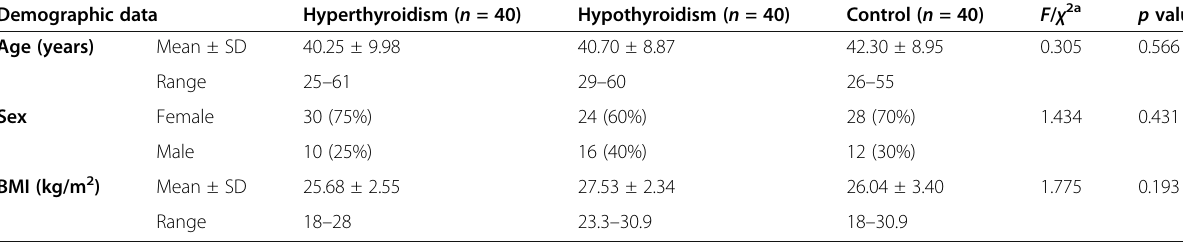
Table 1 Comparison between groups according to demographic data Demographic